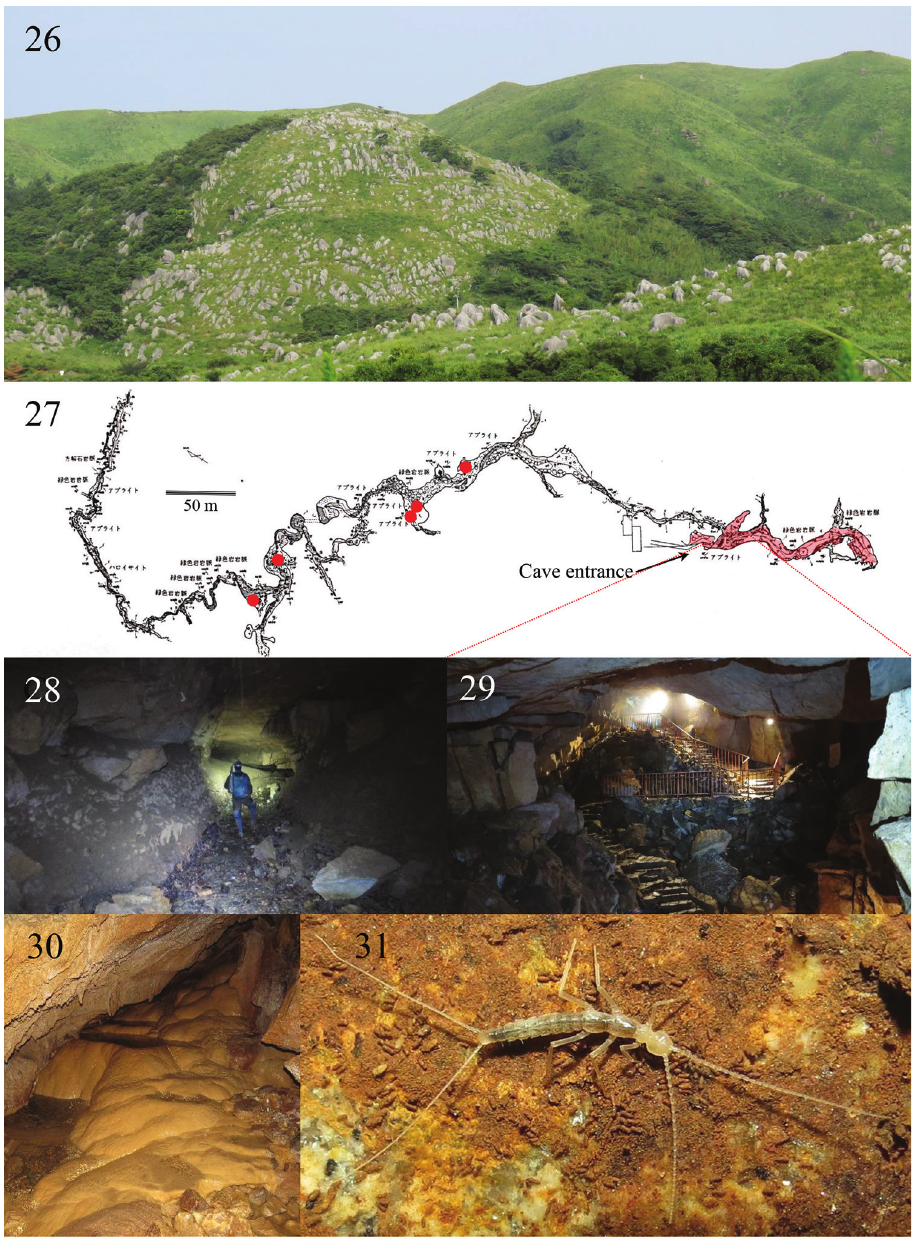
Figures 26–31. 26 Karst landscape in the area where Mejiro-do cave is located 27 Map of Mejiro-do cave, indicating the touristic area (marked in pink), and the locations where specimens of P. daidarabotchi were found (red dots) 28 conduit in the non-touristic area, trespassed by a stream 29 touristic area near the cave entrance 30 speleothems, where some specimens can be observed 31 P. daidarabotchi , living specimen